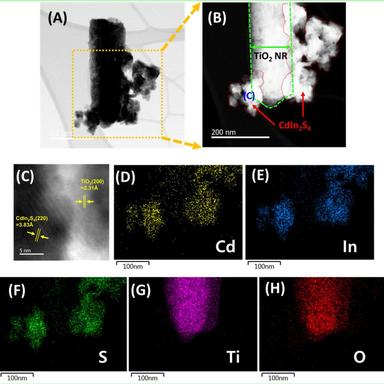
(A) and (B) TEM images of CdIn2S4 deposited TiO2 photoanode, (C) HR-STEM image and elemental distribution mapping images of (D) Cd, (E) In, (F) S, (G) Ti, and (H) O elements of the CdIS/TONR/FTO photoanode.